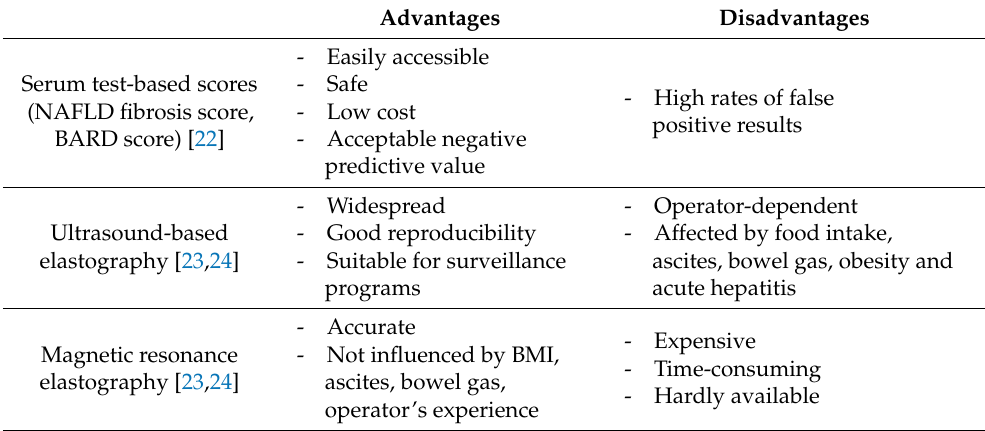
Table 1. Advantages and disadvantages of the currently available techniques for predicting HCC risk in